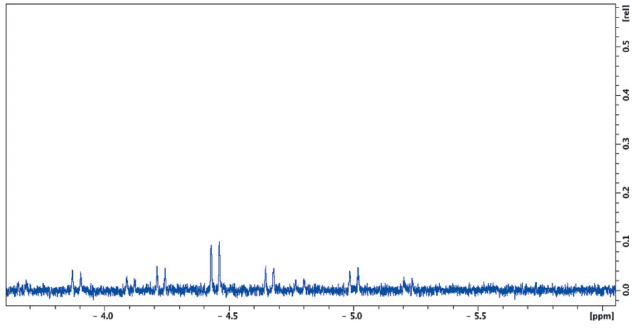
Table 2 Hydrogen-bond geometry (A˚ , (cid:3)